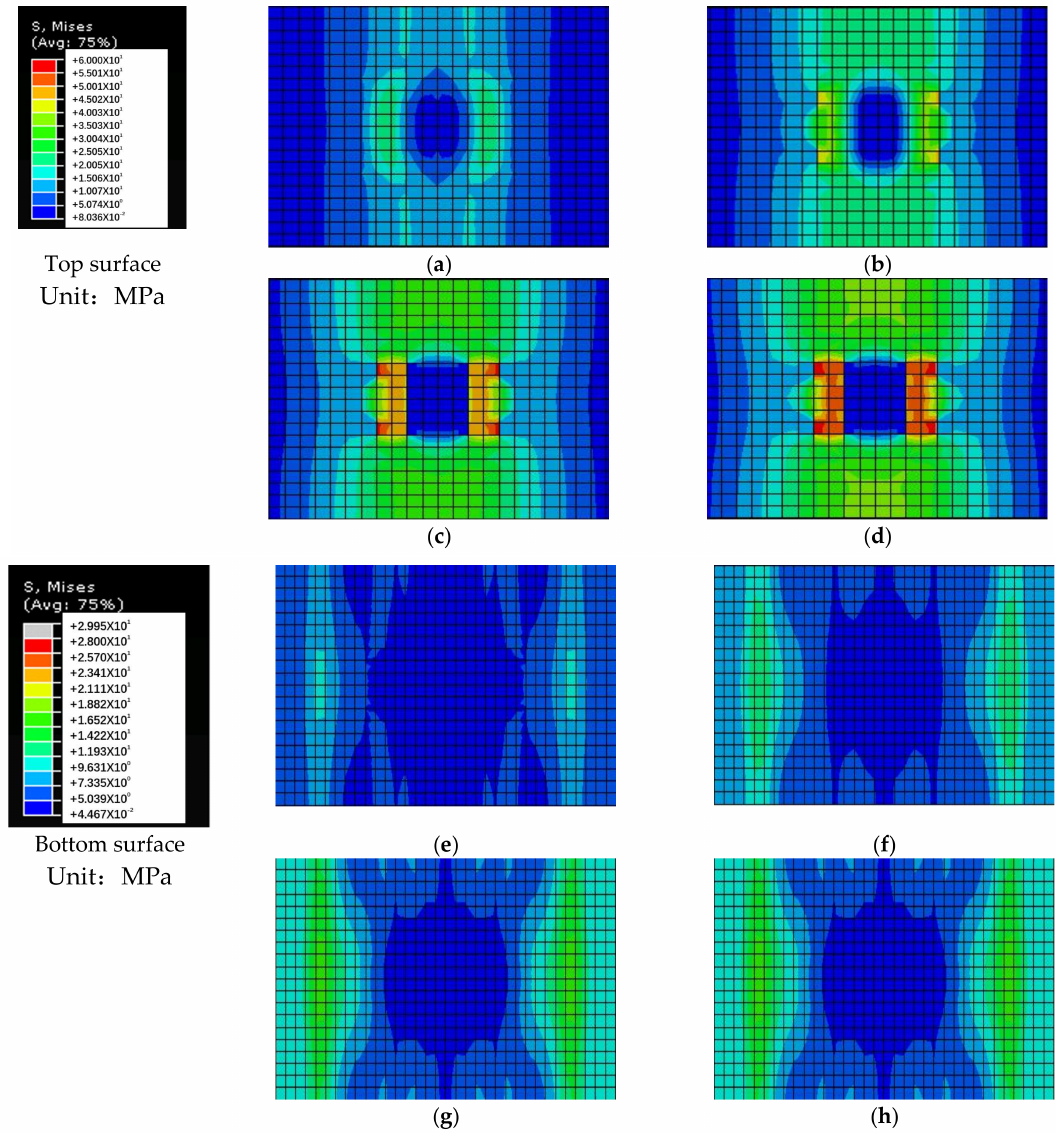
Figure 21. Von Mises stress distribution on the top and bottom surfaces between the W-beams. ( a ) At 50% of the ultimate bearing capacity; ( b ) At 70%; ( c ) At 90%; ( d ) At 100%; ( e ) At 50%; ( f ) At 70%; ( g ) At 90%; ( h ) At